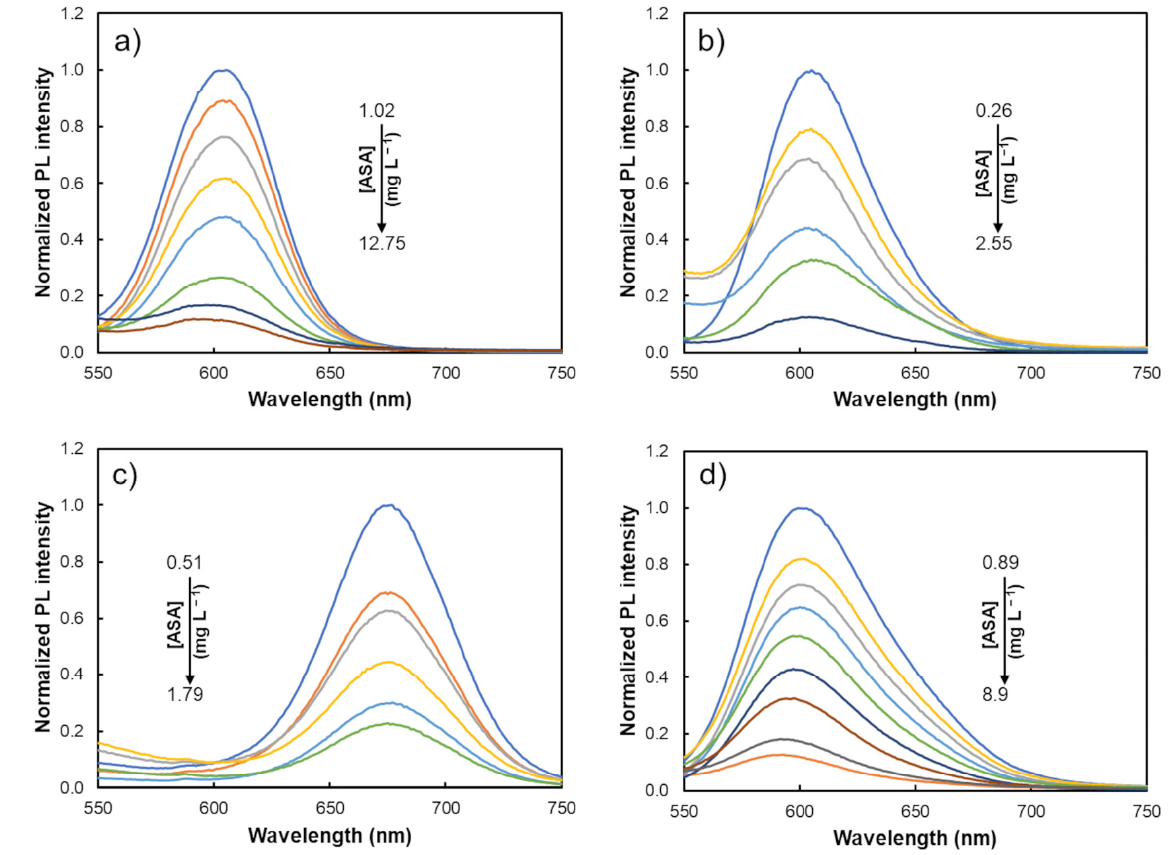
Figure 2. Normalized PL spectra of the nanoparticles sensing platforms: ( a ) TMA-CdTe QDs in the absence and presence of increasing concentrations of acetylsalicylic acid ASA ranging from 1.02 to 12.75 mg L − 1 ; ( b ) GSH-CdTe alone and by adding increasing ASA concentrations between 0.26 and 2.55 mg L − 1 ; ( c ) MPA-CdTe QDs before and after the interaction process with ASA at a concentration level from 0.51 to 1.79 mg L − 1 and ( d ) MES-CdTe QDs alone and upon interacting with increasing concentrations of ASA (0.89–8.9 mg L − 1 ).